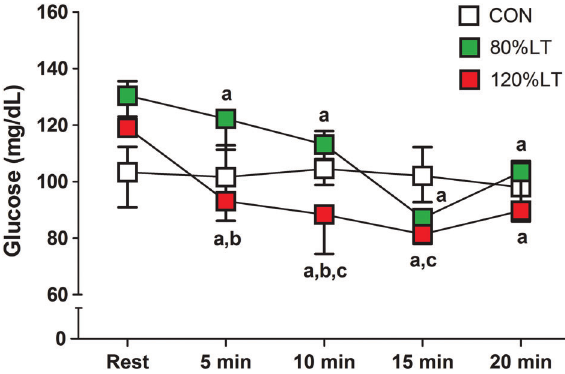
Figure 1. Blood glucose at each 5-min stage during the control, 80%LT, and 120%LT sessions. Data are reported as median, 25th and 75th percentiles). CON: control condition; 80%LT: exercise at 80% of lactate threshold; 120%LT: exercise at 120% of lactate threshold. a P o 0.0125 compared to rest at the same session; b P o 0.0167 compared to 80%LT at the same time; c P o 0.0167 compared to CON at the same time (Friedman ’ s